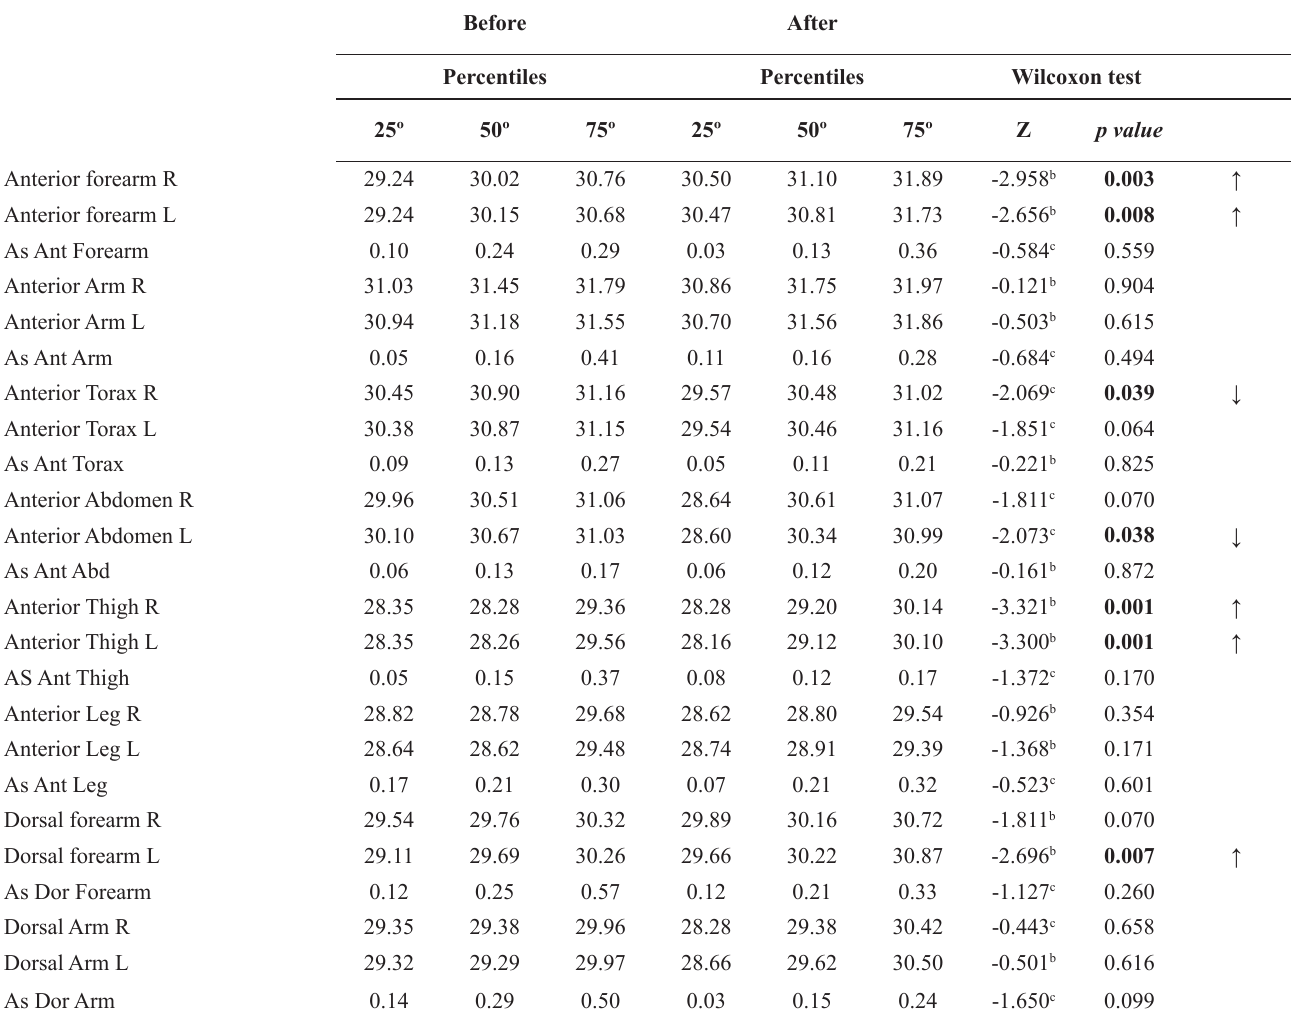
Table 3 - Skin temperature and thermal asymmetries measures of 12 male volunteers, before and after a session of CrossFit® training , Vila Real, Portugal, 2019